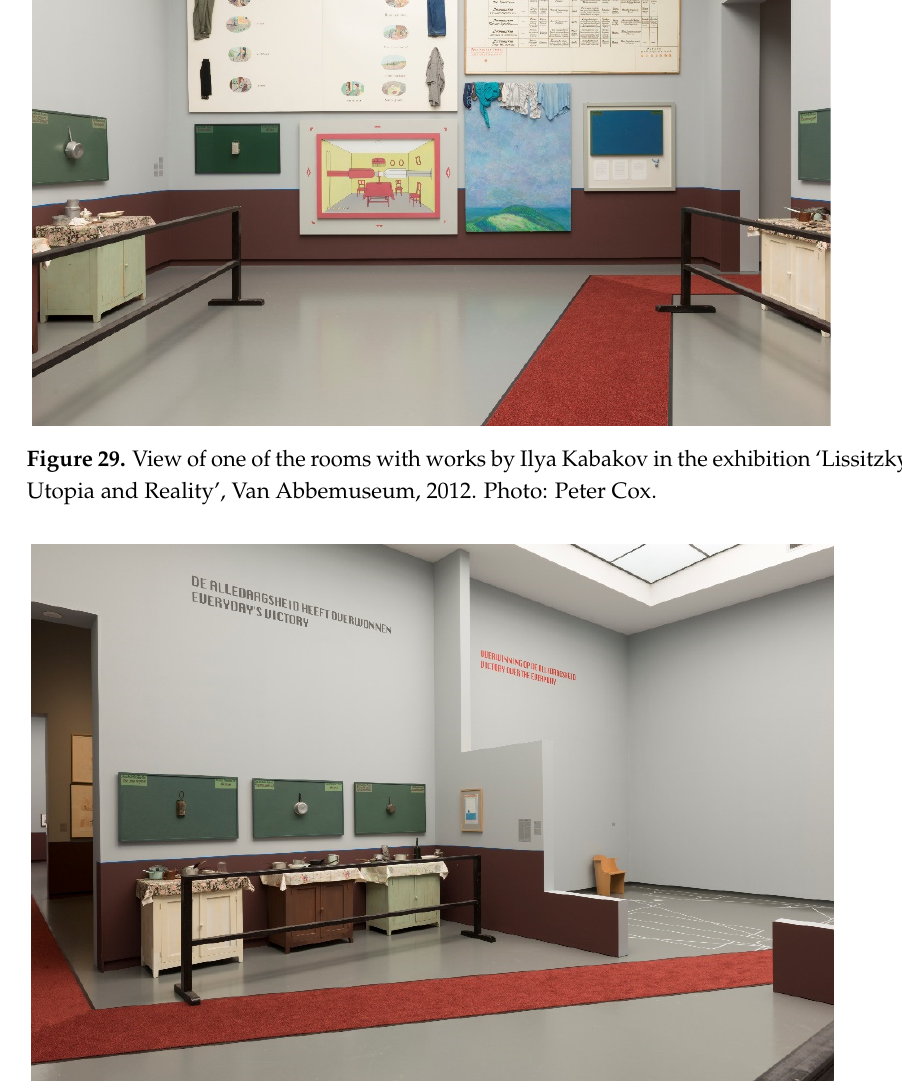
Figure 30. View of one of the rooms in the exhibition ‘Lissitzky–Kabakov: Utopia and Reality’, Van Abbemuseum, 2012. Front: part of the installation by Ilya Kabakov, ‘In the Communal Kitchen’, 1991. Back: El Lissitzky, ‘Armchair of bent plywood’, 1930, reconstruction by Mark van den Heuvel, 2012. On the floor at the back: El Lissitzky, Floorplan for an apartment to solve the housing shortage’, 1930, executed in actual measurements by Van Abbemuseum, 2012. Photo: Peter Cox.